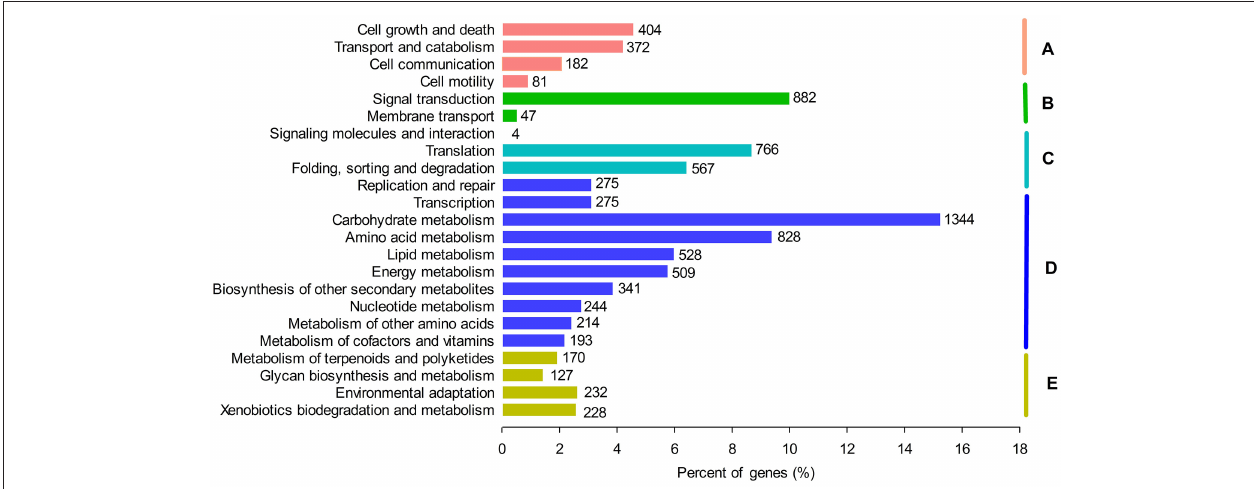
FIGURE 4 | Functional annotation of unigenes based on KEGG categorization. Main functional categories are the Cellular Processes (A) ; Environmental Information Processing (B) ; Genetic Information Processing (C) ; Metabolism (D) ; and Organismal Systems (E) . Bars represent the numbers of Gnetum parvifolium assignments of unigenes with BLASTX matches to each KEGG term.